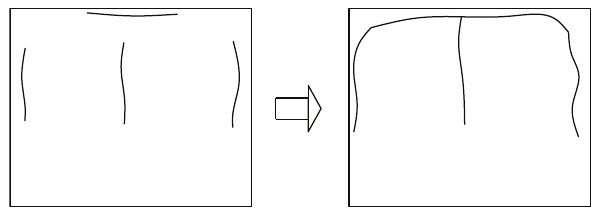
Figure 10: Pattern of roof fractures.